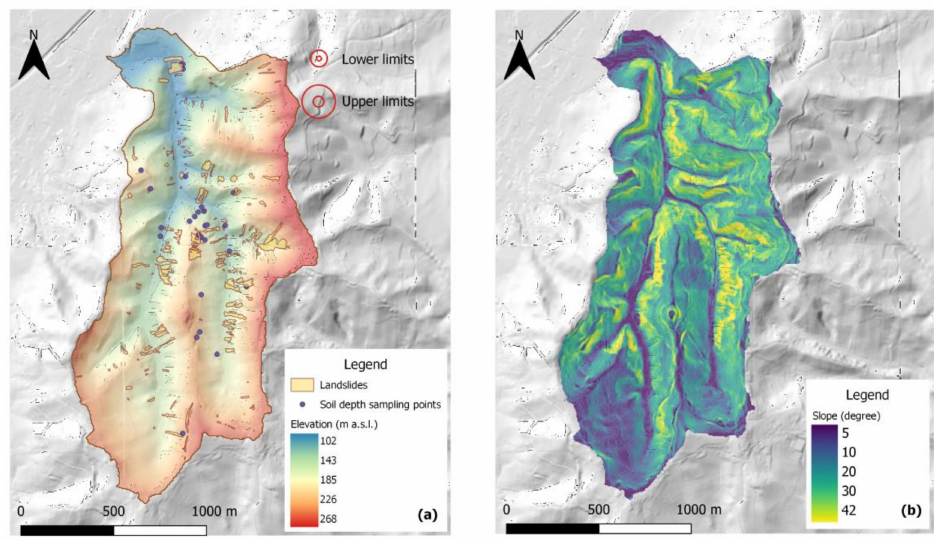
Figure 5. ( a ) Catchment topography with observed landslides triggered after the extreme rainfall on 27–28 April 2009 and location of soil thickness sampling points. Maximum and minimum areas (a min , a max ) considered as lower and upper limits in the optimization process of the slip-surface search parameters for SCCOPS 3D are also represented; ( b ) catchment slope.